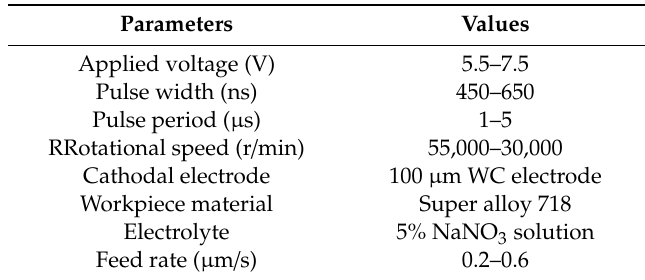
Table 1. Machining conditions for EMM